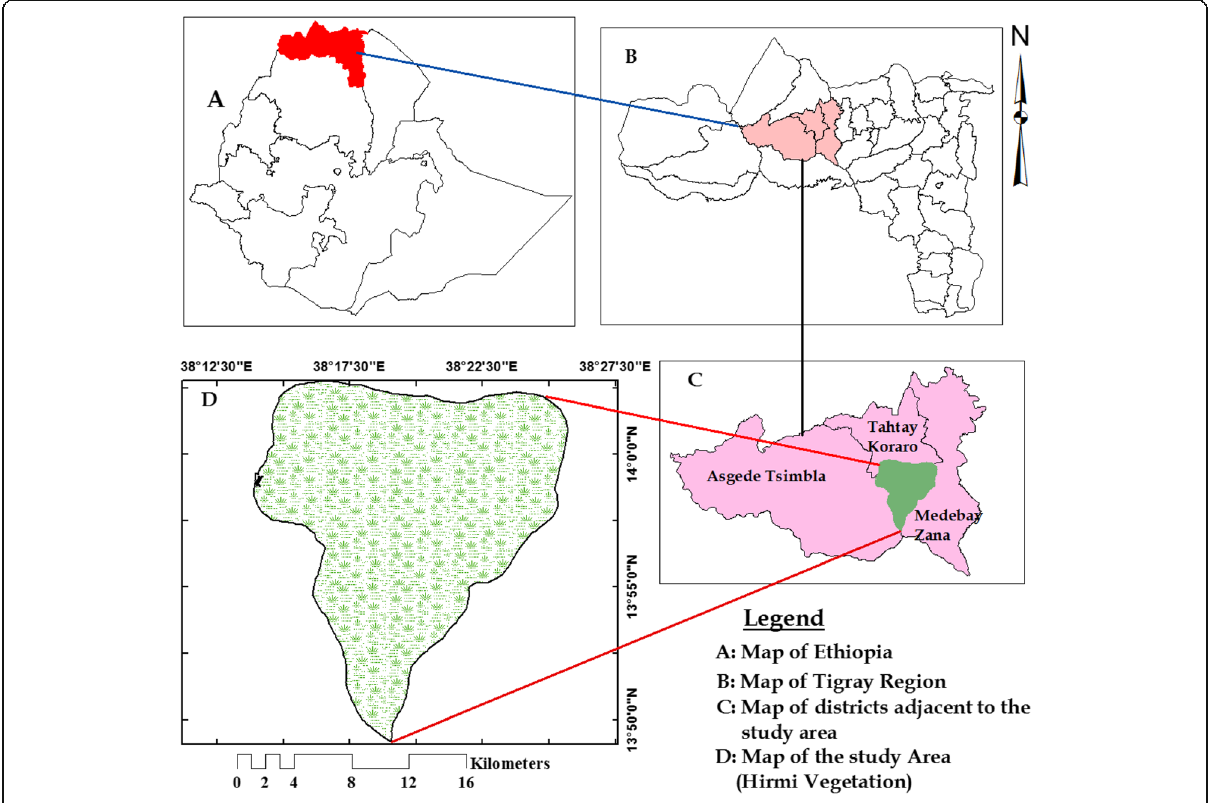
Fig. 1 Map showing position of the study area